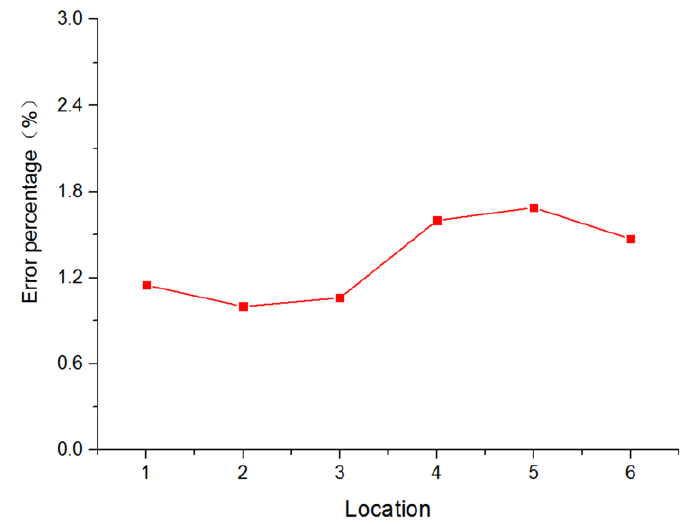
Figure 20. Error percentage of measured positions.